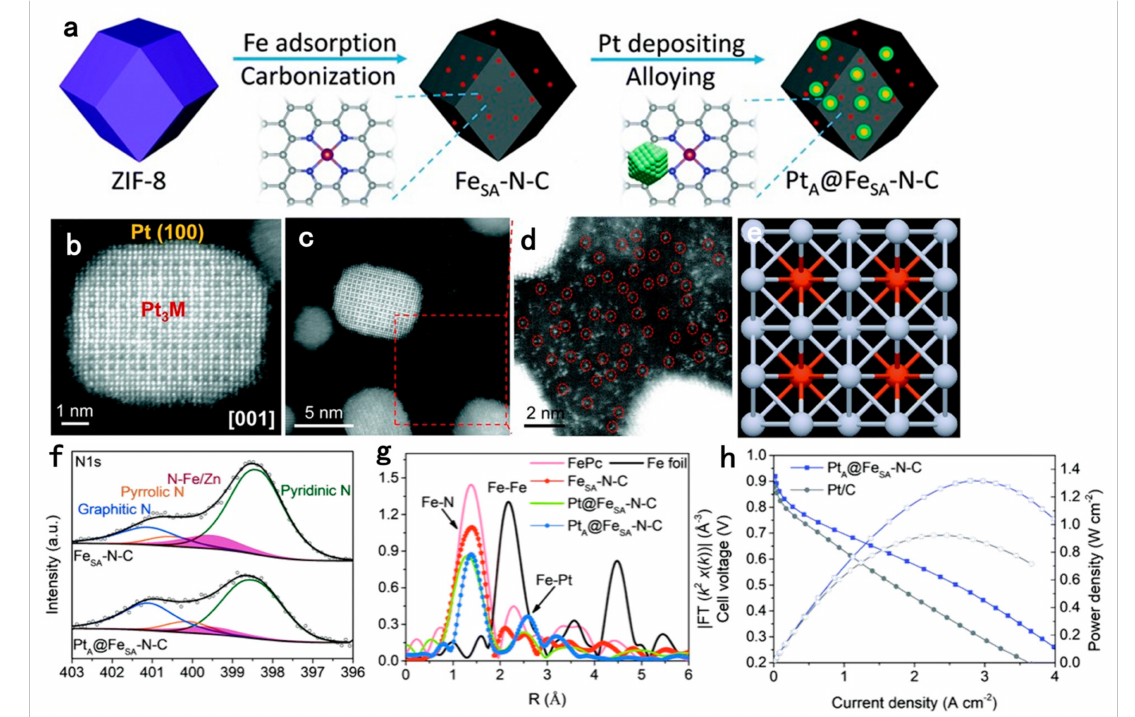
Figure 7. ( a ) Schematic illustration of the preparation of Pt A @Fe SA –N–C. ( b – d ) HAADF-STEM images of Pt A @Fe SA –N–C. ( e ) Crystal structure of ordered Pt 3 M viewed along the [001] zone axis (the red and grey spheres present M and Pt atoms, respectively). ( f ) XPS spectra of N 1s for Fe SA –N–C and Pt A @Fe SA –N–C. ( g ) FT-EXAFS spectra of Fe SA –N–C, Pt@Fe SA –N–C, Pt A @Fe SA –N–C and reference materials at the Fe K-edge. ( h ) The I–V (solid symbols and lines) and I–P (hollow symbols and dashed lines) curves of the H 2 –O 2 fuel cell. The cathode loading is 0.13 mg Pt /cm 2 ; the pressure is 1.0 bar; and the cell temperature is 65 ◦ C [147]. Copyright 2020 Royal Society of